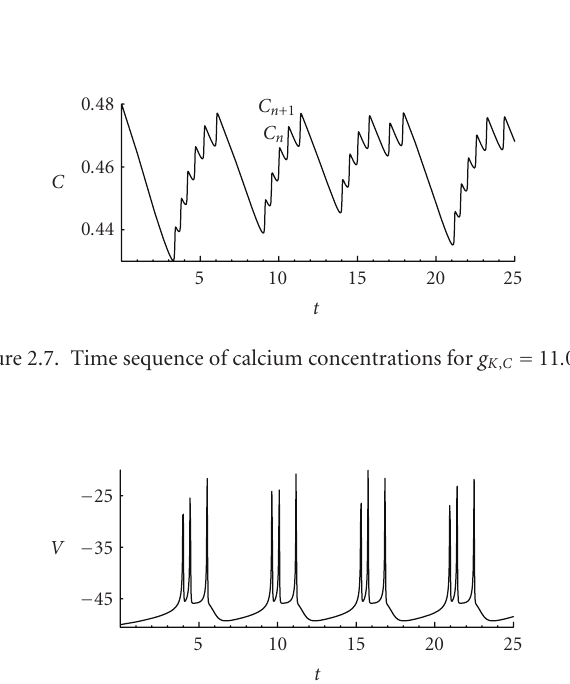
Figure 2.6. Time sequence of membrane potentials for g K , C = 11 . 0 s − 1 (irregular firing pattern).